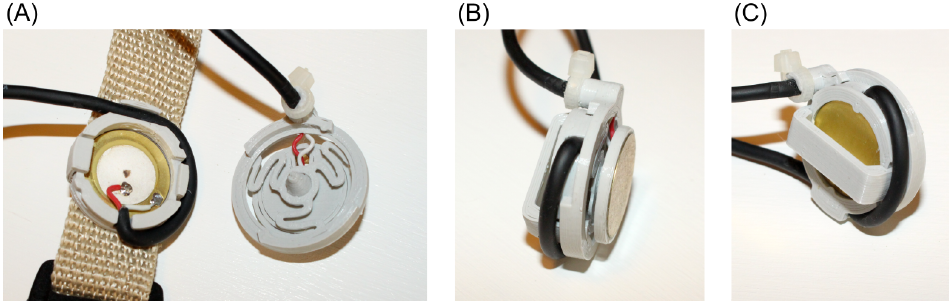
Figure 1. The designed mechanomyograpic (MMG) sensor: ( A ) side view and ( B ) section (A-A) through the pin of the coupler. The piezoelectric discs are marked with an orange color.